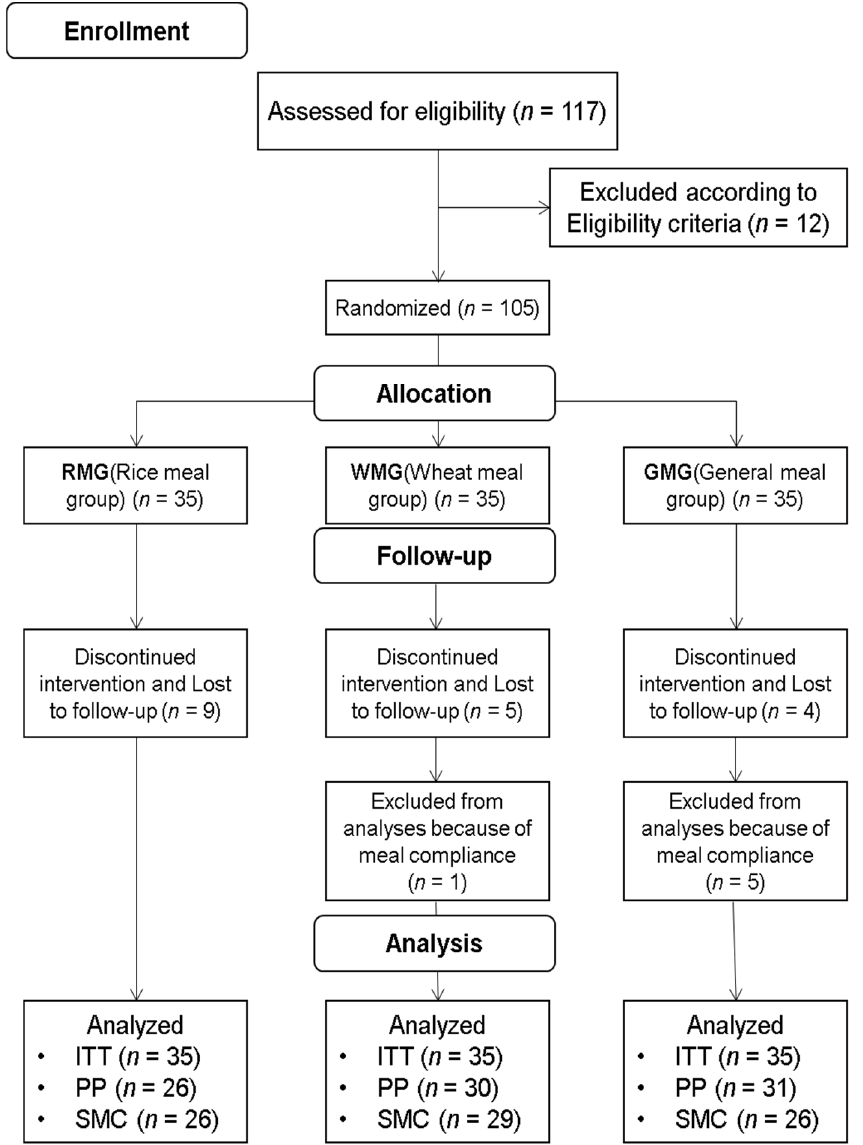
Figure 1. The CONSORT diagram. ITT: intention-to-treat; PP: per-protocol set; SMC: suitable meal compliance.